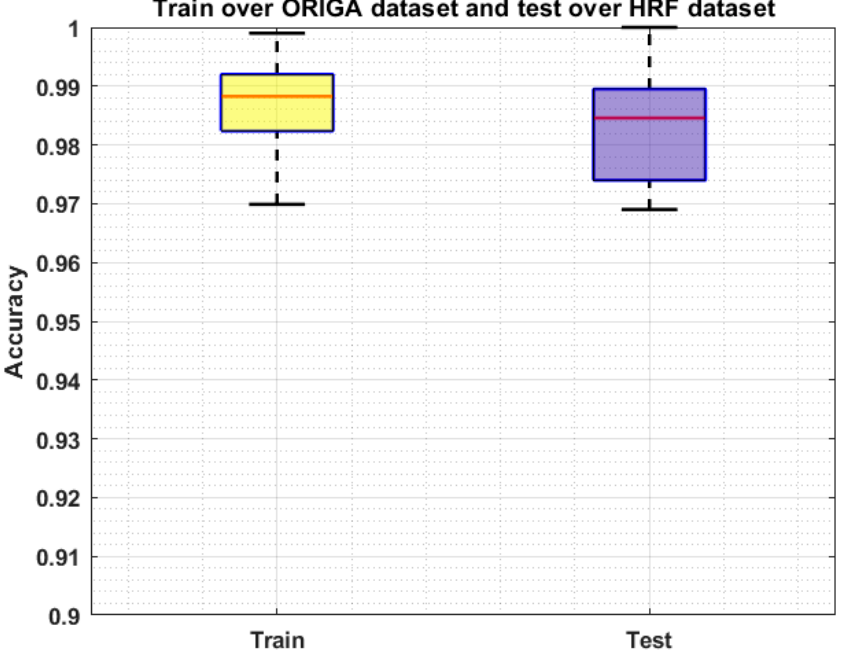
Figure 8. Cross-Validation Results where the model is trained on the ORIGA dataset and test on the HRF dataset.